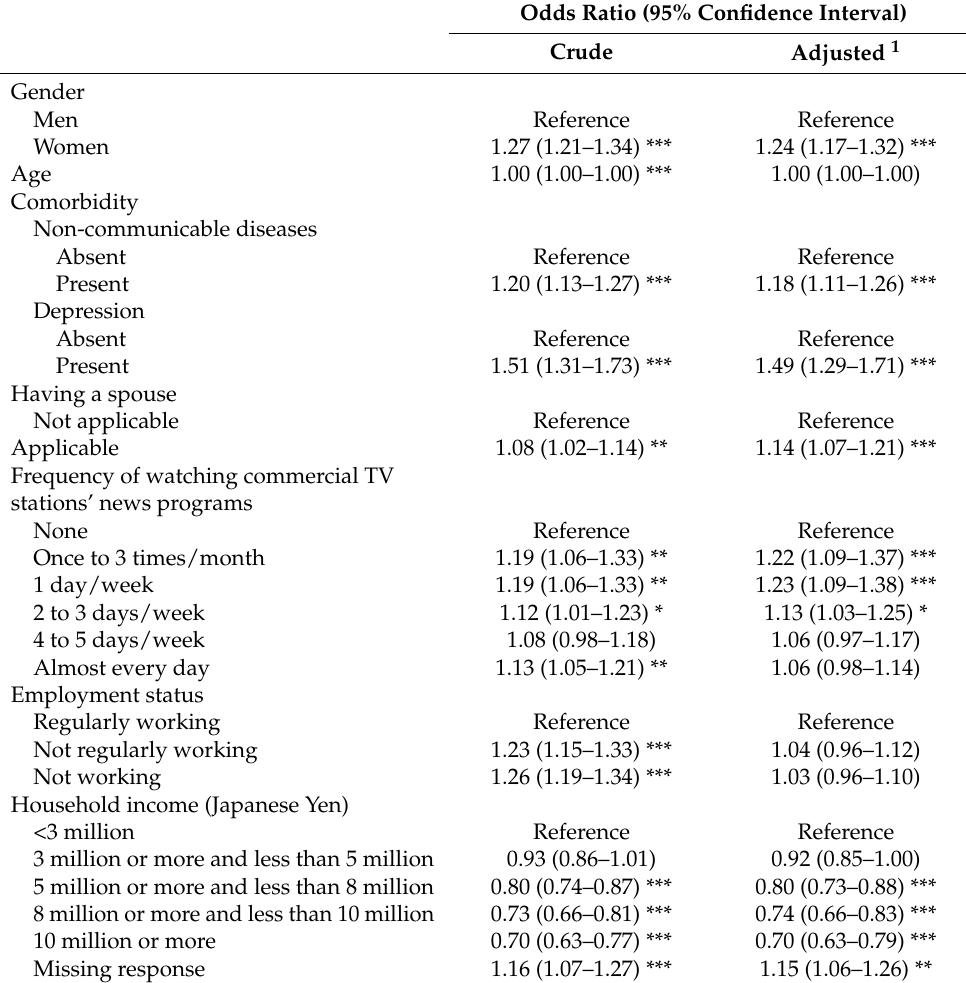
Table 5. Odds ratios for reporting a median or higher Fear of COVID-19 Scale score: multiple logistic regression